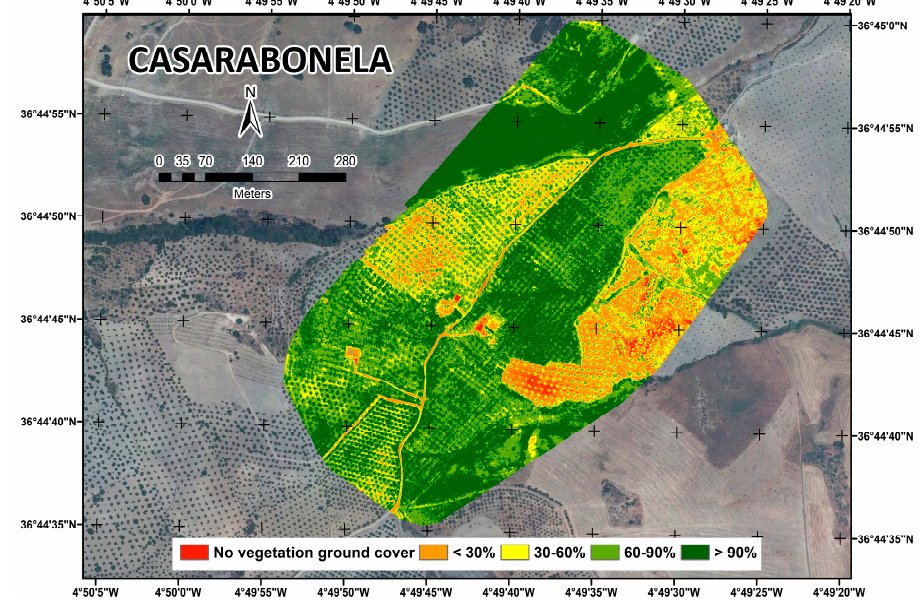
Figure 8. Quantification map of the VGC in Casarabonela, made at a cover interval range of 30% using IRVI index.